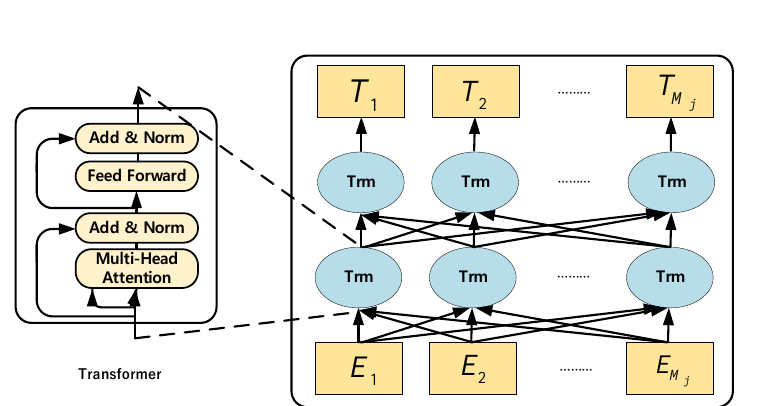
Figure 4. Structure of BERT.